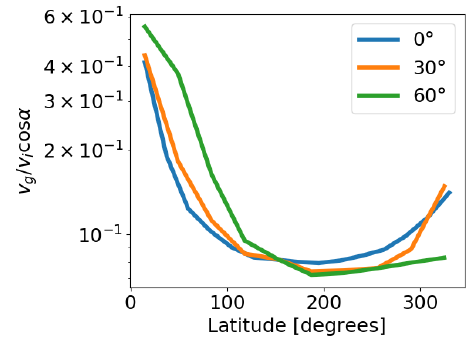
Figure 7. Ground velocity ratio (ground velocity divided by the normal of impactor velocity) from the shock as a function of the position of the planet, for three different colliding angles. The ratio between the impactor and target radii is 0.01. The fact these curves are similar to one another demonstrates that in the self similar shocks lose some of the information about the initial conditions.